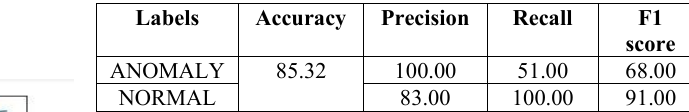
TABLE. II. Random Forest Metrics